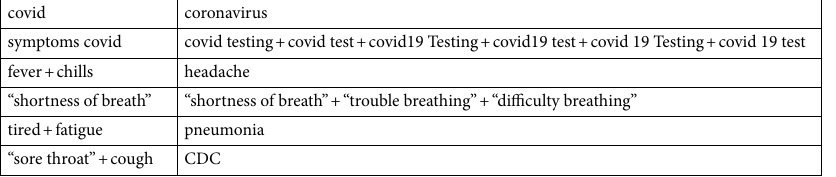
Table 1. Google Trends search terms used. Google Trends search terms with no punctuation will contain the term(s), along with other words, in any order. Using double quotation marks give results that include that exact term, possibly with words before and after. The use of a plus sign ( +) is shorthand for